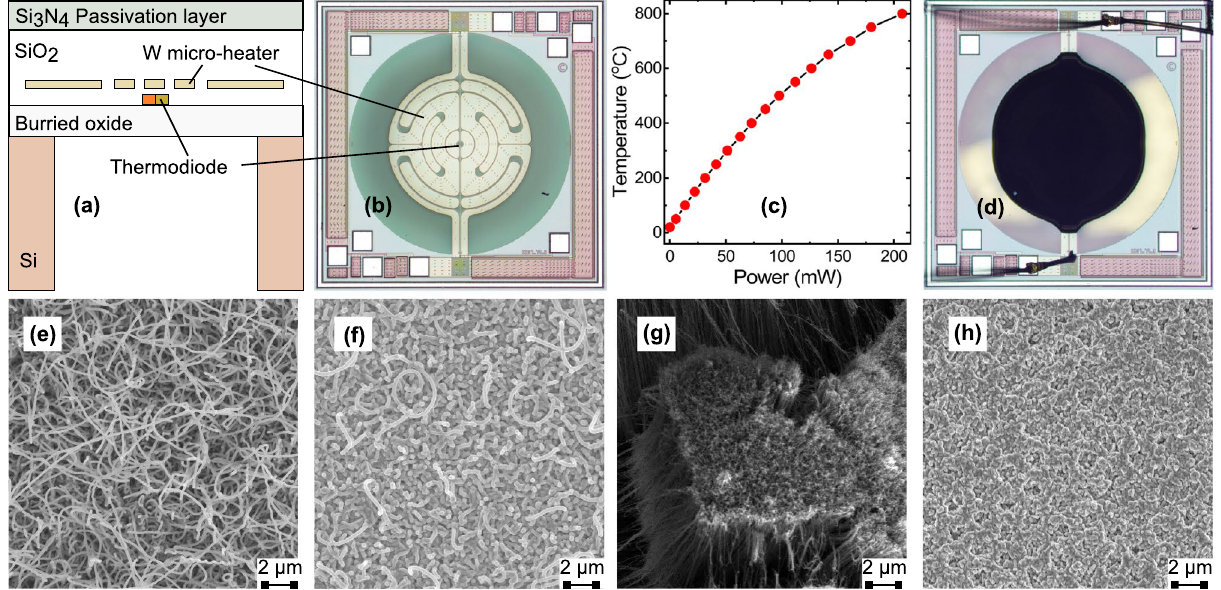
Figure 1. Device fabrication. ( a ) Micro-hotplate cross-section (not to scale) employing a tungsten (W) heating element embedded into a ∼ 5 µ m thick silicon dioxide (SiO 2 ) membrane formed by deep reactive ion etching. ( b ) Optical image of the micro-hotplate, showing a multi-ring designed heating element surrounded by the membrane. Chip size = 1.76 mm × 1.76 mm. ( c ) Micro-heater temperature as a function of power consumption. ( d ) The active heating element serves three purposes: (i) localised in-situ heating (micro-reactor) during the CNT growth process; (ii) employed as thermal profiler (adlayer flashing) for self-annealing; and (iii) used to generate IR emission during device operation (typically at temperatures of 300–600 ◦ C). ( e ) Typical SEM image of spaghetti-like CNT structure grown by an in-situ CVD process using acetylene (C 2 H 2 ) blended with ammonia (NH 3 ) over an iron (Fe) catalyst, and ( f ) their SEM image after ∼ 50 nm alumina (Al 2 O 3 ) encapsulation. ( e ) SEM image of denser, more aligned CNTs synthesised by mixing C 2 H 2 with hydrogen (H 2 ), and ( h ) their SEM image after